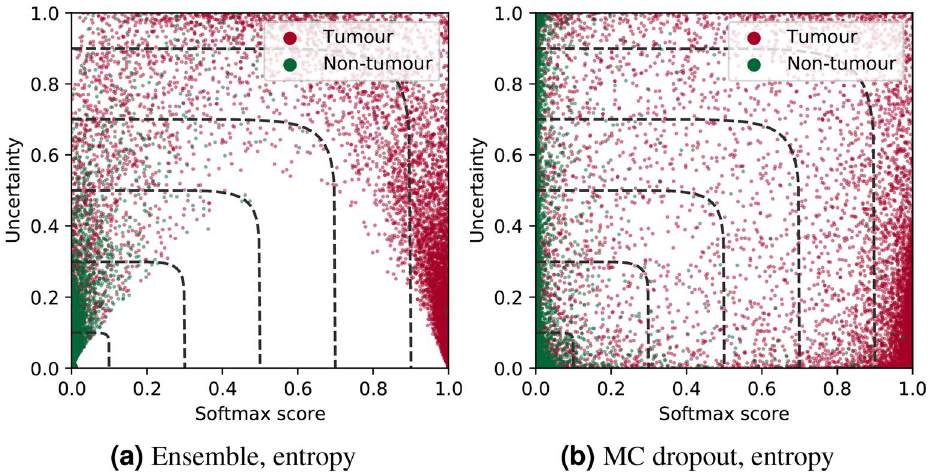
Figure 3. Relation between softmax confidence and estimated uncertainty, for two different uncertainty methods. The points show the testset from Camelyon16, with colors encoding ground truth class labels. The dashed lines illustrate the 2D threshold used for classification based on both softmax and uncertainty, for a set of different threshold values.